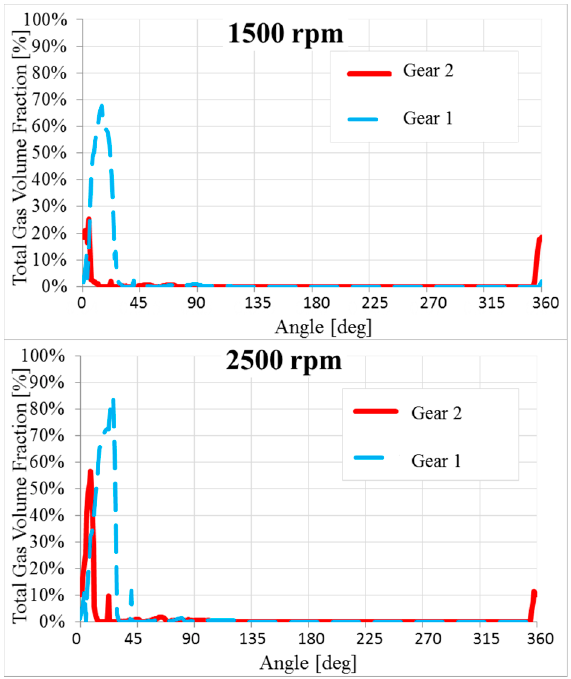
Figure 20. Total gas fraction behaviors at 1500 and 2500 rpm.